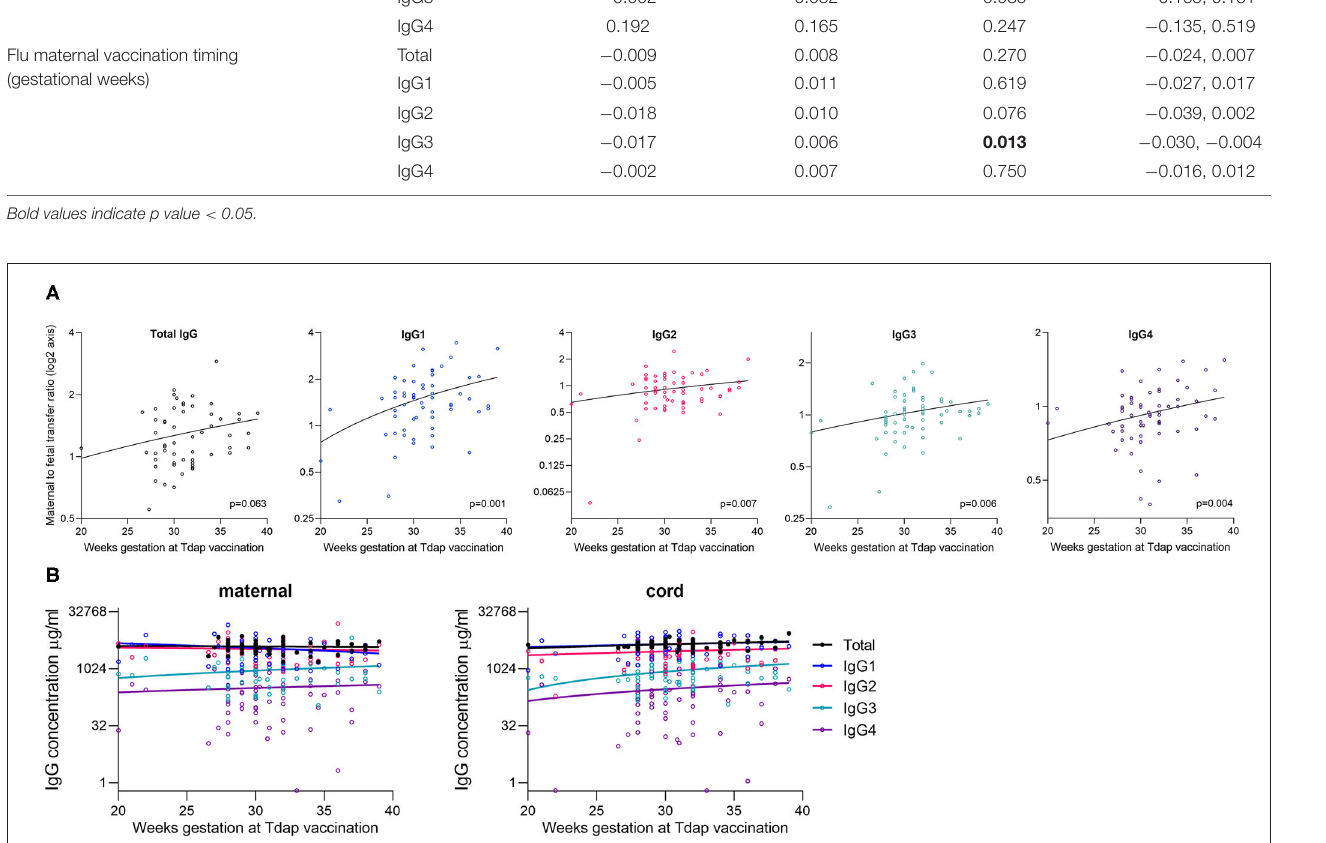
FIGURE 6 | Correlation between gestation at Tdap vaccination and placental transfer of total IgG and IgG subclasses. (A) Correlation between the gestation that pregnant women received the Tdap vaccine and the maternal to fetal IgG transfer ratio for total IgG and IgG subclasses [log(2) Y -axis]. Analysis was performed on log(2) transformed ratios by Spearman’s rank correlation coefficient, and resultant p values are stated in the bottom right corner of each plot. Coefficients: Total IgG: 0.242, IgG1: 0.316, IgG2: 0.171, IgG3: 0.353, and IgG4: 0.316. (B) Correlation between the gestation at vaccination and the antibody concentration in maternal blood and cord blood at birth. Analysis performed on log-transformed data by Spearman’s rank correlation coefficient. All correlations non-significant at p > 0.05 level. Lines indicate simple linear regression. Coefficients for maternal IgG: Total IgG: − 0.044; p = 0.752, IgG1: − 0.145; p = 0.262, IgG2: − 0.180; p = 0.161, IgG3: 0.013; p = 0.919, IgG4: 0.029; p = 0.823. Coefficients for cord IgG: Total IgG: 0.235; p = 0.079, IgG1: 0.197; p = 0.125, IgG2: 0.134; p = 0.296, IgG3: 0.164; p = 0.199, and IgG4: 0.191; p = 0.133. N =